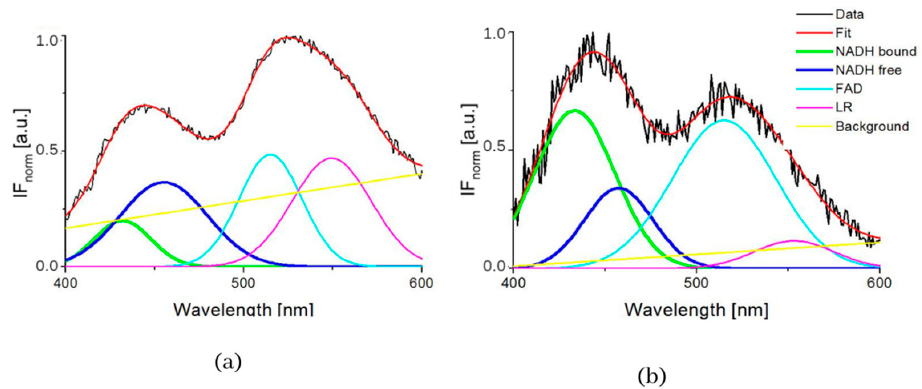
Figure 2. GASpeD decomposition of the normalized fluorescent spectra ( a ) 3T3 sample S4 (healthy cells), ( b ) CT26 sample S1 (carcinoma cells).